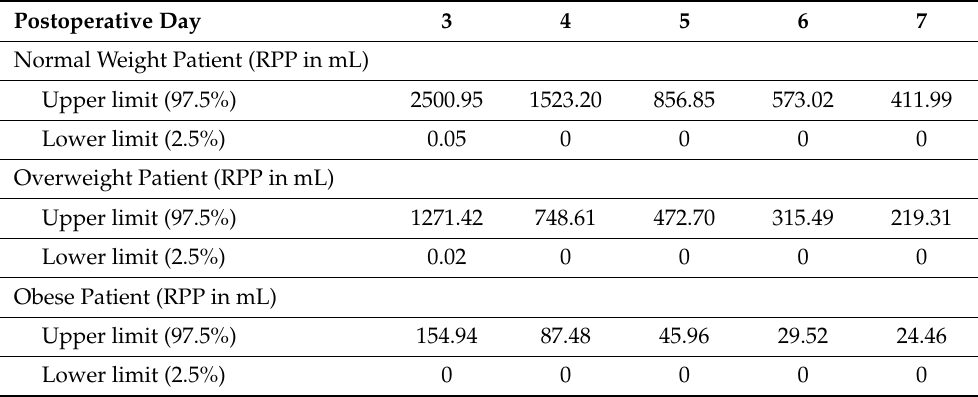
Table 2. Calculated RPP at post-operative day 3, 4, 5, 6, and 7 showing 95% credible intervals for patients in each of the three BMI